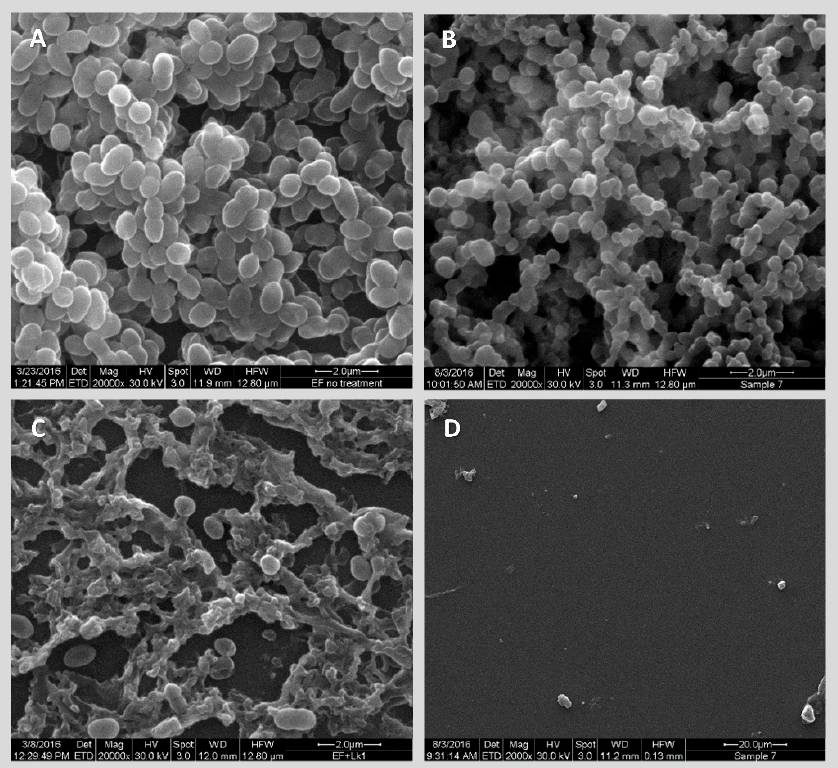
Figure 6. Combinations of phage EFLK1 and vancomycin target VRE. Scanning electron